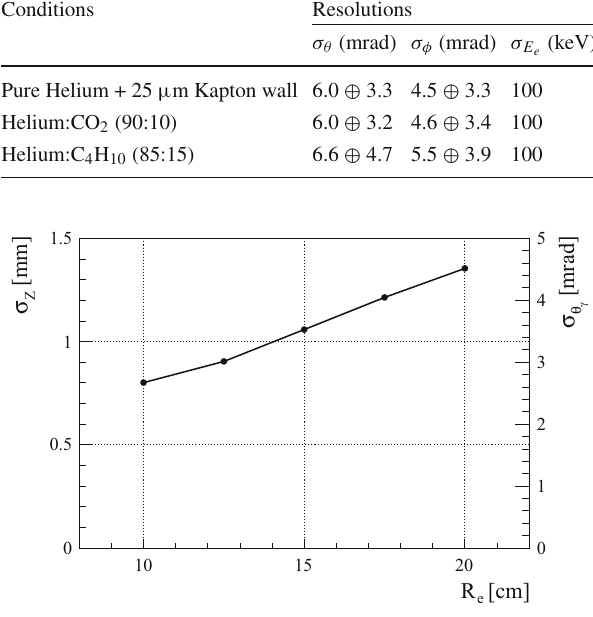
Fig. 4 Vertex resolution in the Z coordinate as a function of the inner radius of the tracking detector. It gives a contribution to the θ e γ res- olution which equals approximately σ Z / R γ , being R γ the radius of the photon detection point. The right axis shows this contribution for R γ = 30 cm. It has to be added to the contribution from the positron θ angle